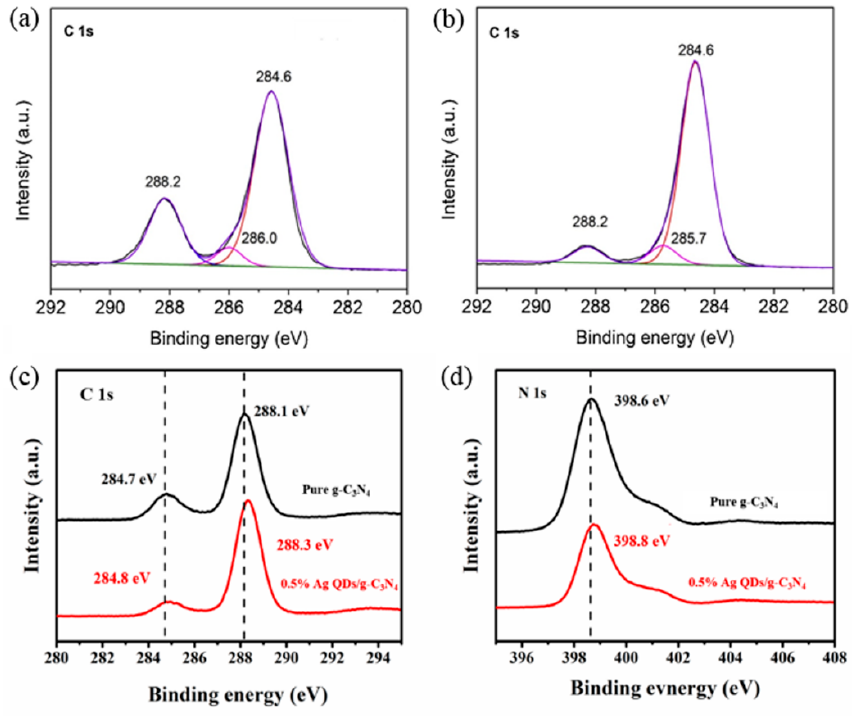
Figure 17. XPS spectra of ( a ) C 1s of g-C 3 N 4 /ZnTcPc, ( b ) C 1s of g-C 3 N 4 /ZnTcPc/0.1GQDs